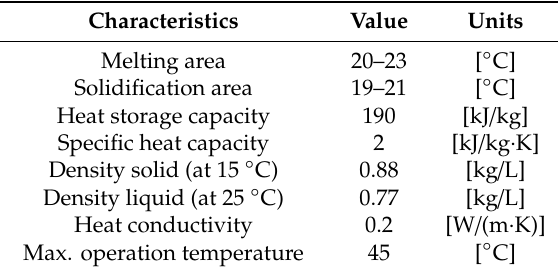
Table 1. RT 21 HC Material properties.